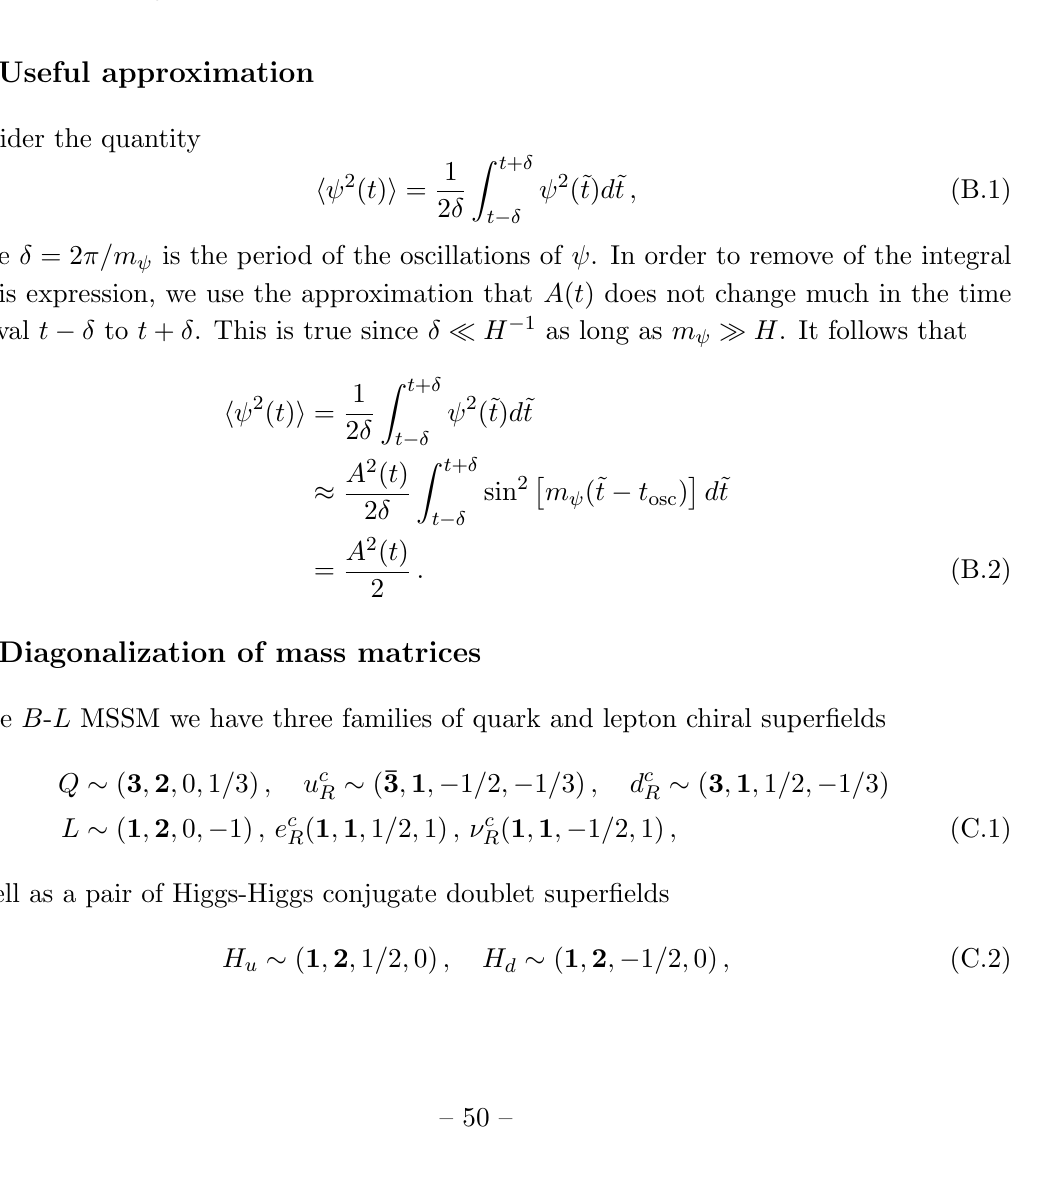
expresses the 1 fM 2 BL 2